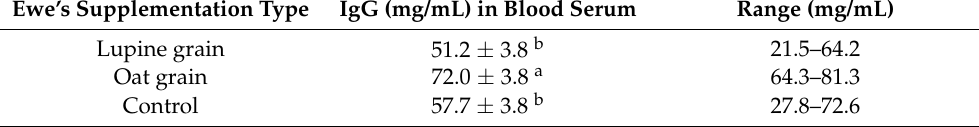
Table 5. Concentration of IgG in the blood serum of newborn lambs at 24 h postpartum (least square means ± standard error), under different maternal supplementation modalities, during the last third of